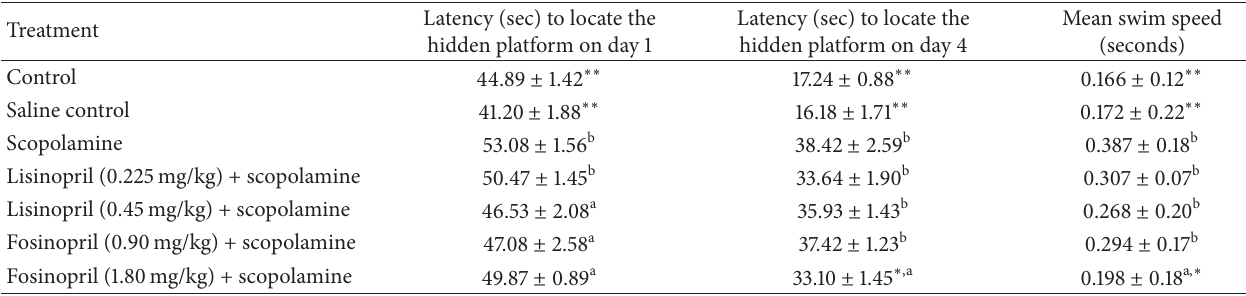
Table 4: Effects of lisinopril and fosinopril during acquisition trials in Morris water maze test.